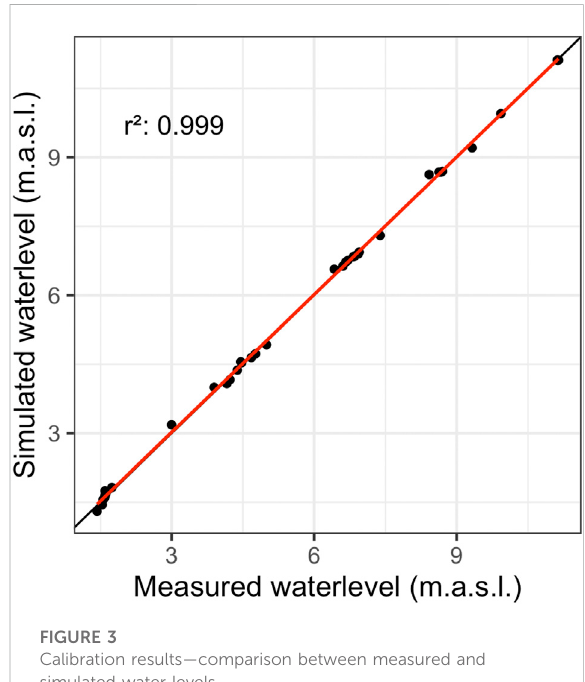
FIGURE 3 Calibration results — comparison between measured and simulated water levels.